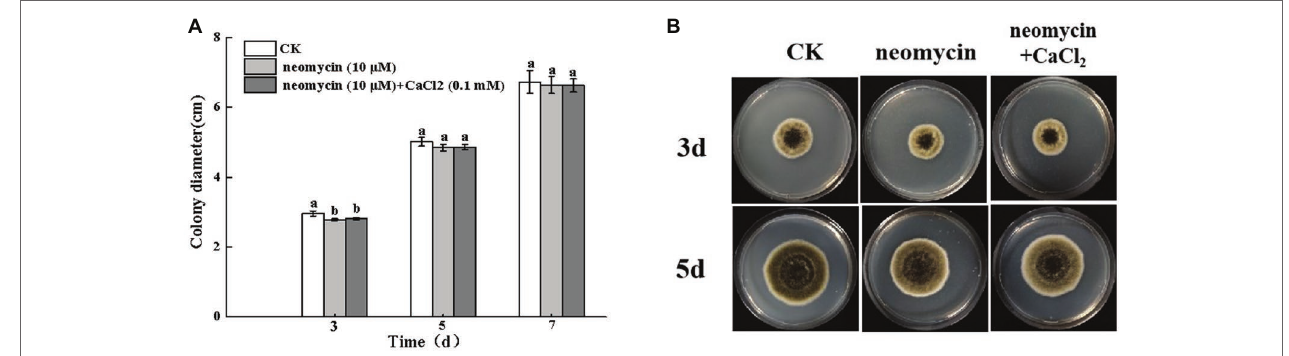
FIGURE 4 | Effects of PLC on A. alternata mycelial growth (A) and colony morphology (B) . Condia (1 × 10 6 ) from A. alternata were inoculated onto potato dextrose agar (PDA) medium and plates were imaged after 3 and 5 days incubation at 28 ° C. Vertical lines indicate standard error (± SE ) of the means. Different letters indicate significant differences ( p < 0.05).